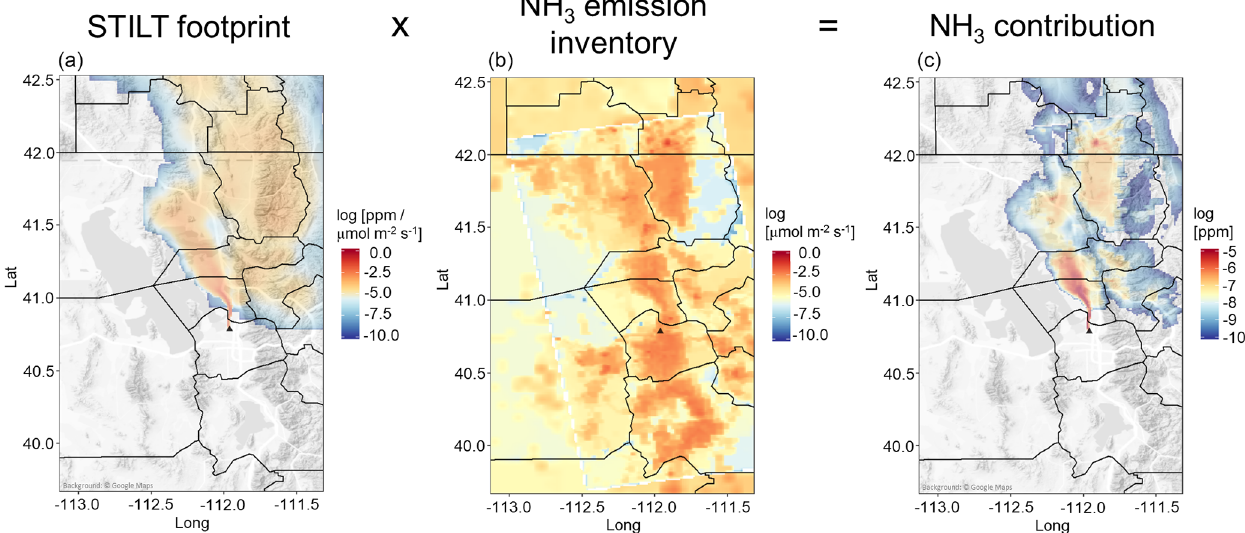
Figure 5. Approach used to determine NH 3 enhancements by overlaying the emission sensitivity map (in ppmv(µmolm − 2 s − 1 ) − 1 , a ) with the NH 3 emissions from the UDAQ emission inventory (in µmolm − 2 s − 1 , b ). The emission sensitivities were derived with STILT for every 2min of the Twin Otter flight path for all research flights. NH 3 enhancement for the Twin Otter location were obtained by summing all NH 3 contributions within the spatial domain of the NH 3 contribution map (c) . The NH 3 emission inventory map (b) is a composite of the 1.33 × 1.33km 2 resolution emission inventory in the centre, imbedded into the 4 × 4km 2 emission